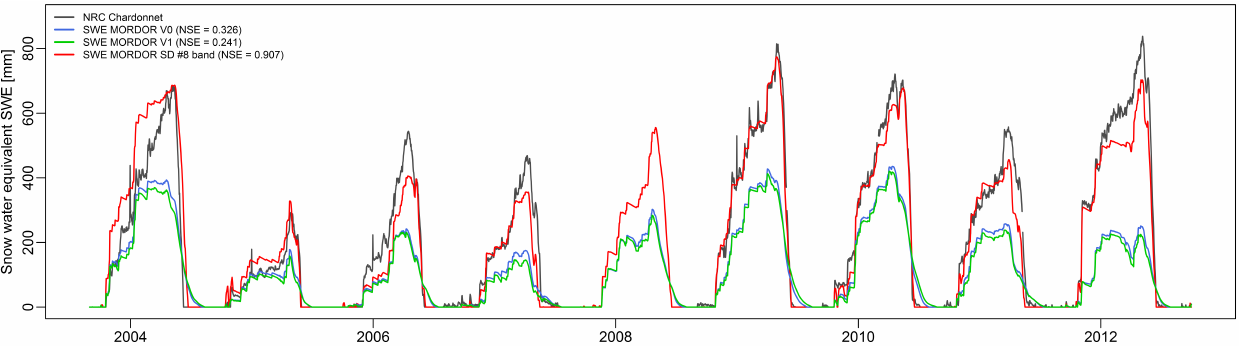
Figure 6. Observed and simulated snow water equivalent (SWE) time series on the Durance at La Clapière catchment. NSE values are calculated on SWE time